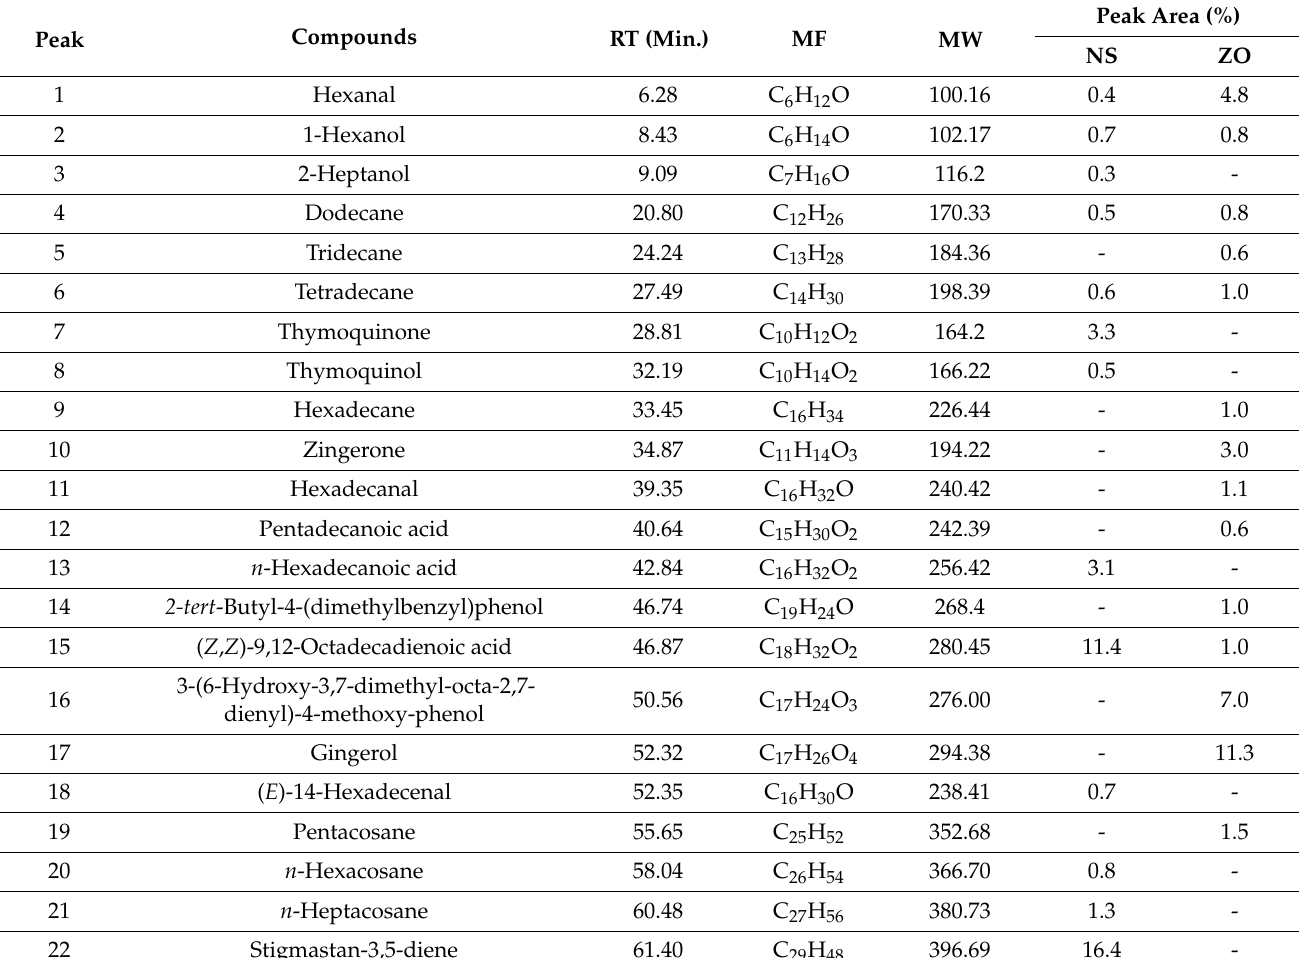
Table 1. Identified chemical compounds from N. sativa and Z. officinale